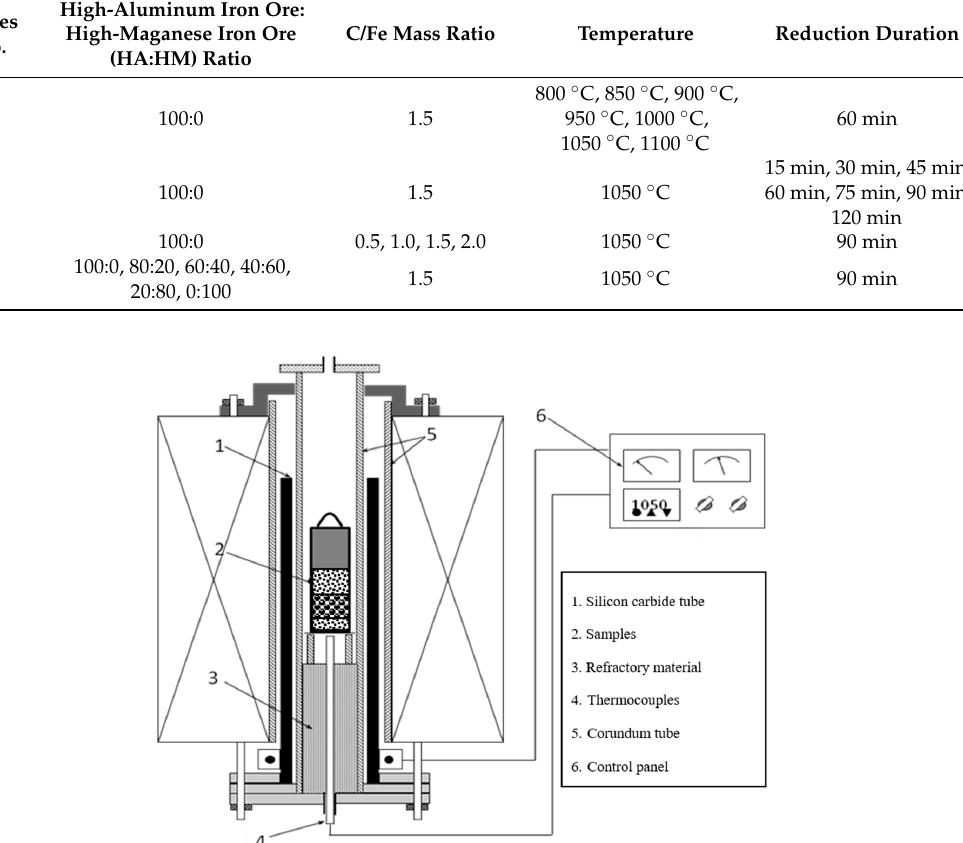
Figure 4. Effect of reduction temperature on metallization degree of reduced pellets of high-